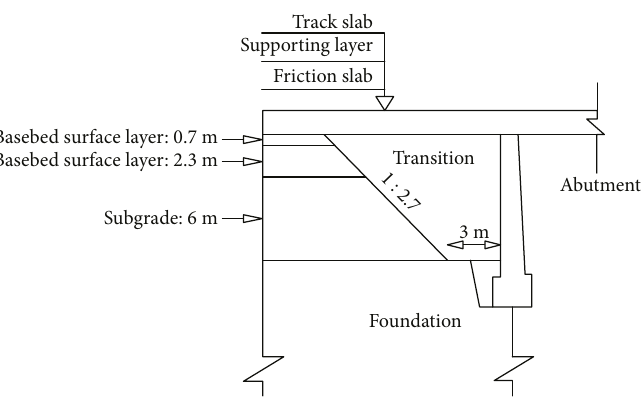
Figure 6: Geometric model of transi t ion section.